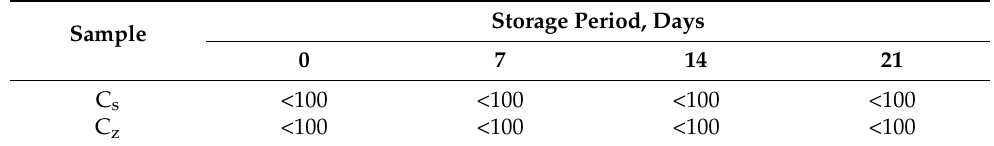
Table 4. Yeasts and molds enumeration during storage, CFU/g.